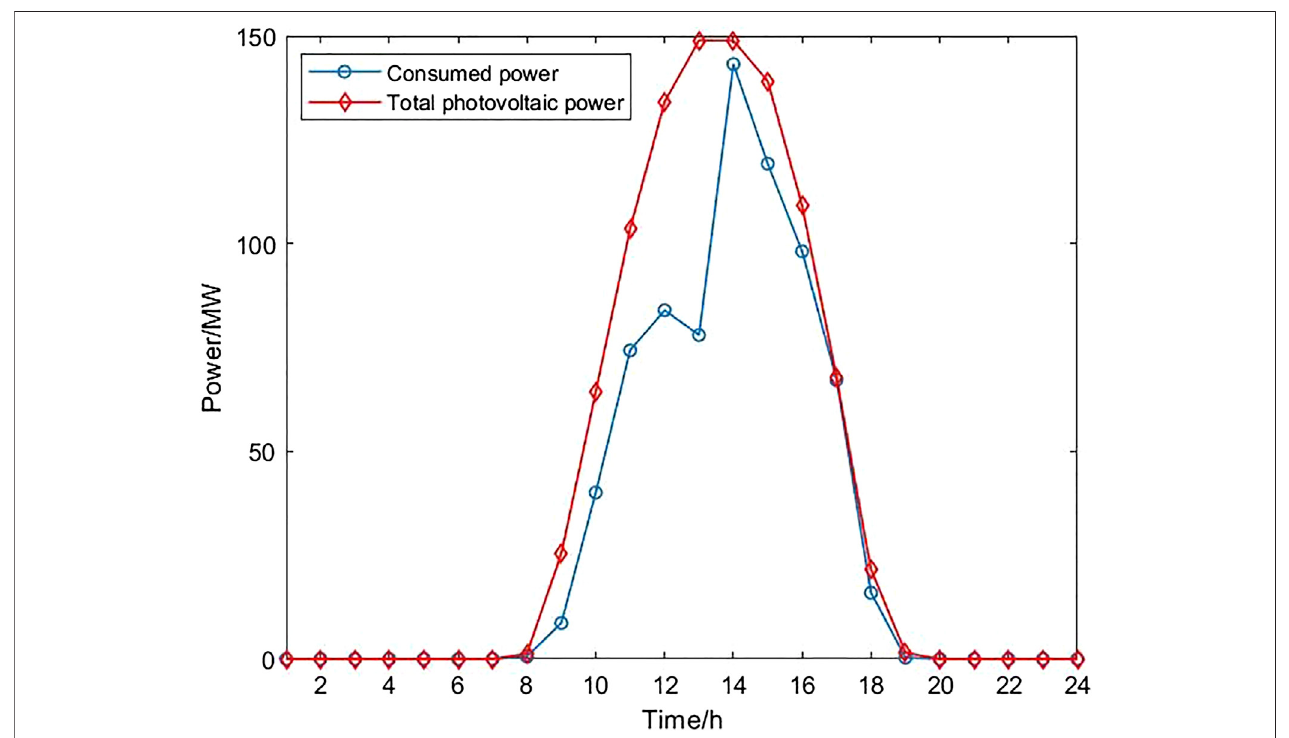
FIGURE 5 | Simulation results of photovoltaic power consumption.